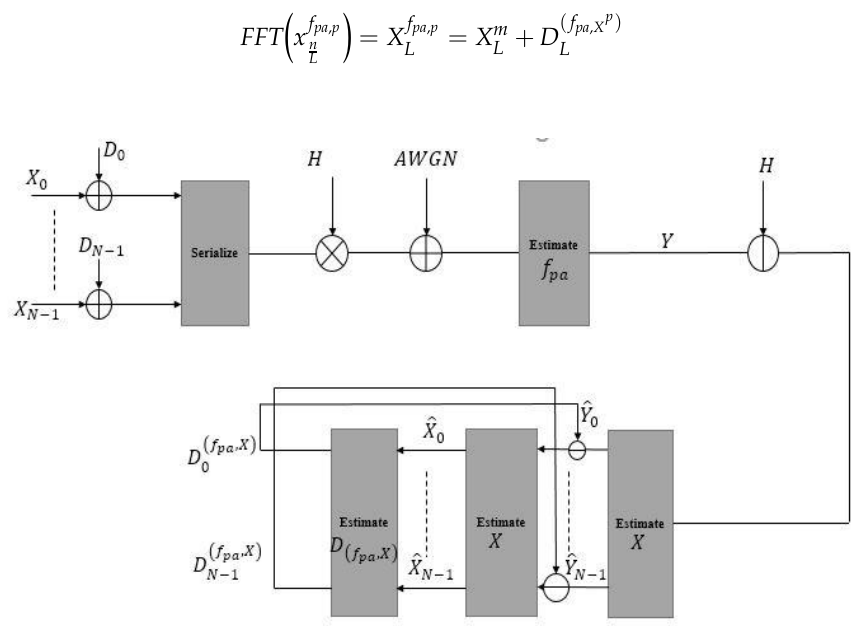
Figure 5. Frequentative decision feedback (FFB) model.